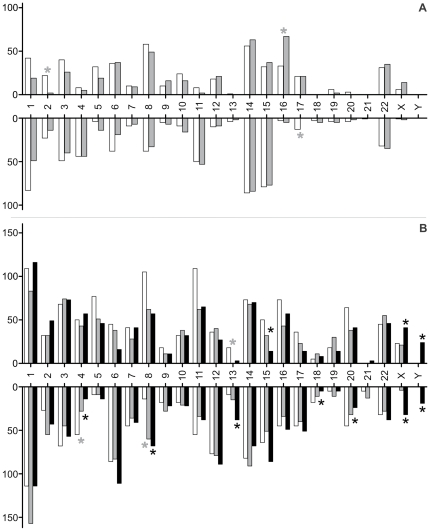
Number of duplications (upwards) and deletions (downwards) per chromosome (normalised per 100 men) detected by 244A (A) and 400K (B) arrays for normozoospermic controls, oligozoospermic and SCOS patients (open, grey and black bars, respectively).Significantly different frequencies between the groups are marked with an asterisk. P-values calculated by Fisher's exact test. To correct for multiple testing, P-level for significance was adjusted according to the Bonferroni-Holm procedure.